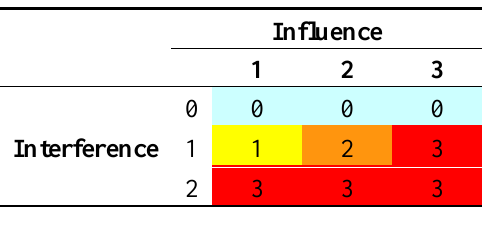
Table 1. Matrix of pressure as a function of interference and